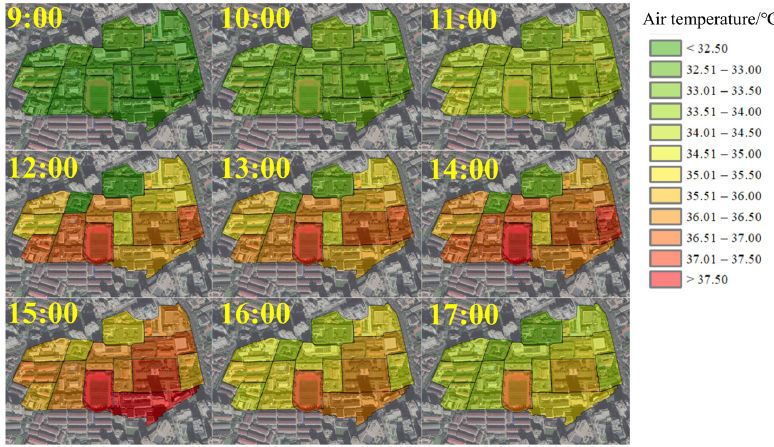
Figure A1. Hourly air temperature maps in the university campus region.